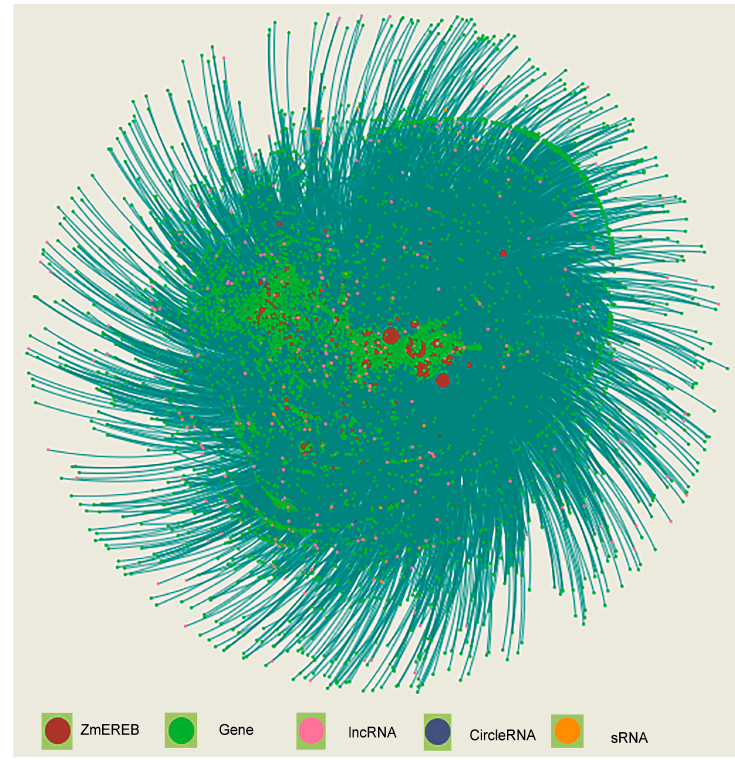
Figure 2. The integrative networks mediated by AP2/ERFs. Moreover, the benefit of the large-scale screening yeast libraries, the potential partner of maize AP2/ERFs could be obtained [95]. Using maize AP2/ERF genes as a query, a total of 21,228 interactions were discovered, of which 120 AP2/ERFs interacted with 9820 proteins. Most of the AP2/ERFs can interact with more than one protein, and some of them can interact with more than 100 proteins (Figure 3), indicating that AP2/ERFs mediated